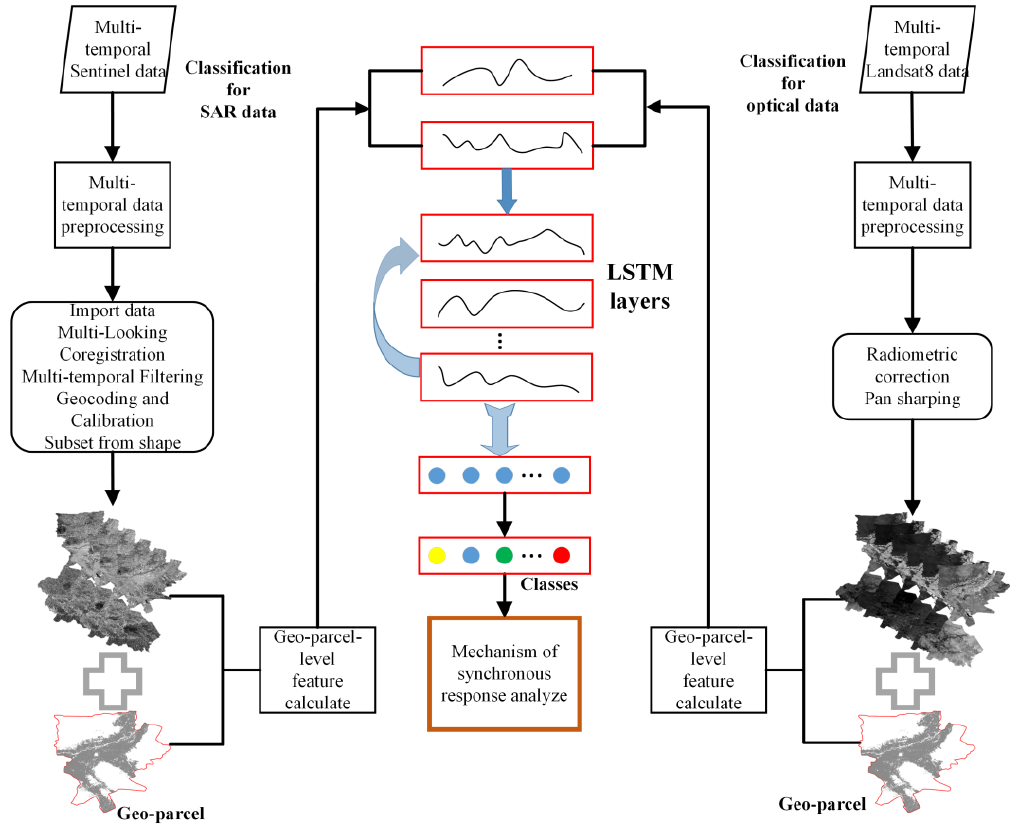
Figure 3. Workflow for the synchronous response relationship analysis of the crop features.